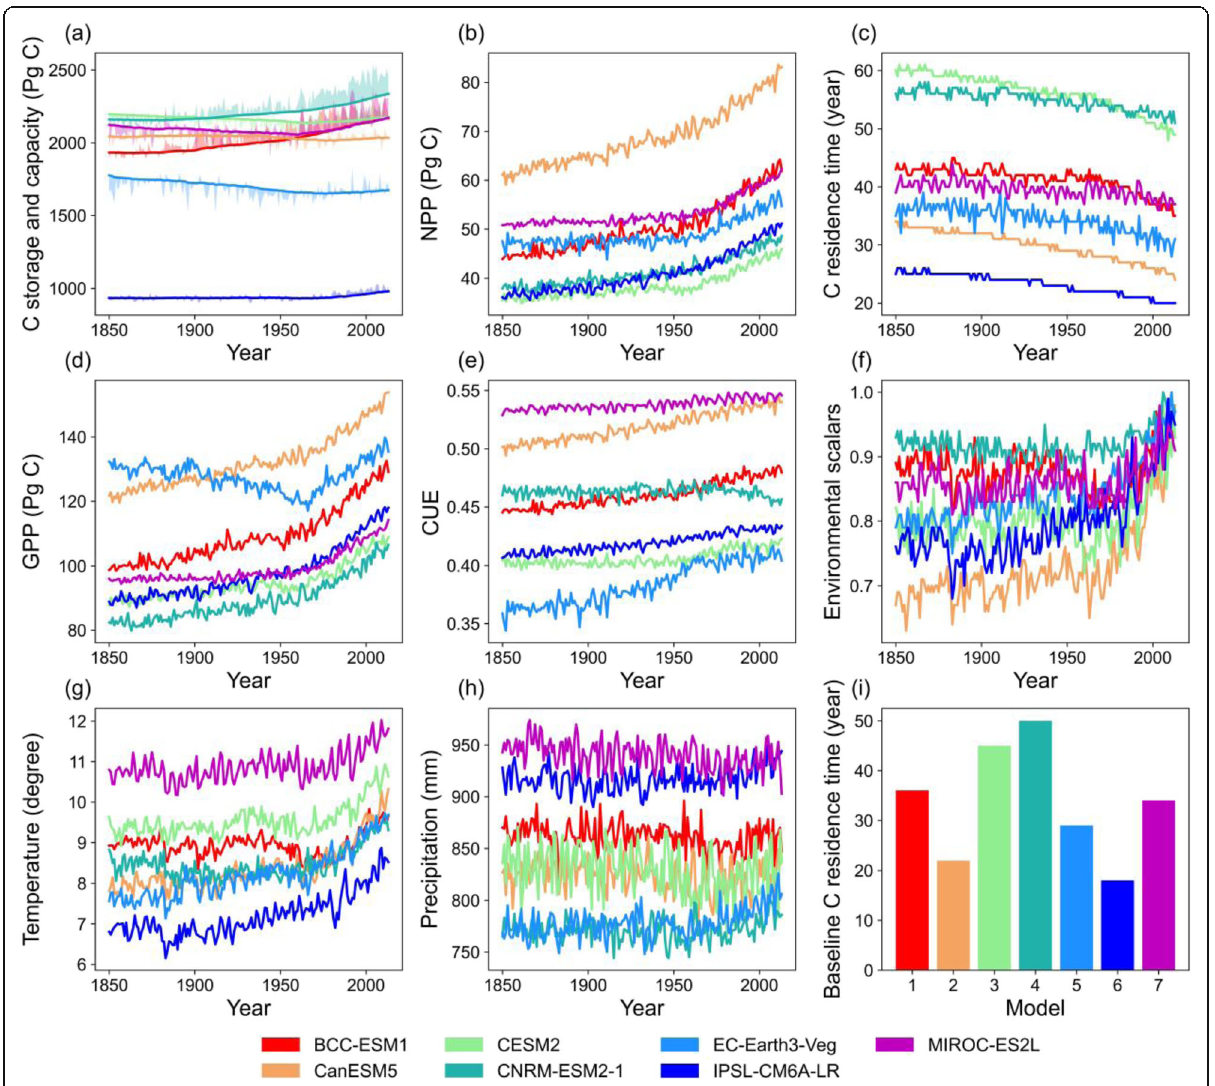
Fig. 3 The time series of annual carbon (C) storage (solid lines) and C storage capacity (the contour lines) ( a ), and the traceable components: b – h for net primary productivity (NPP), C residence time, gross primary productivity (GPP), C use efficiency (CUE), environmental scalars, temperature, and precipitation simulated by seven CMIP6 models, respectively. i The baseline C residence time for each model. The shades in ( a ) represent the annual variation in C storage potential for models (positive above the solid lines, and negative below the solid